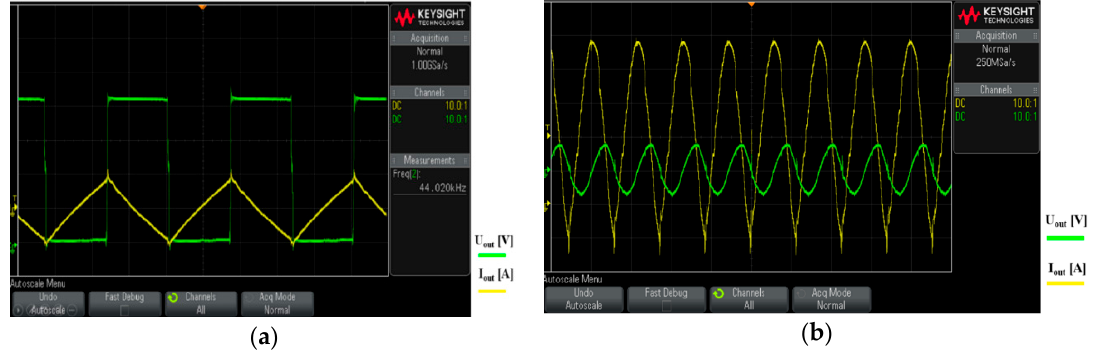
Figure 22. Di ff erence between ( a ) hard switching; ( b ) soft Figure 22. Difference between ( a ) hard switching; ( b ) soft switching.